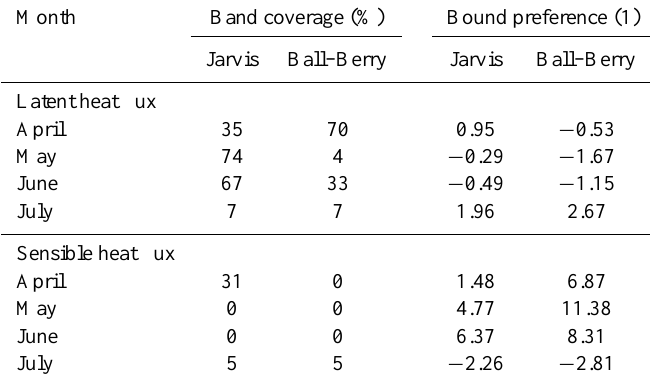
Figure 8. Measured and simulated monthly average diurnal cycles of sensible heat flux over a winter wheat stand in southwest Germany. For modelling, the NOAH-MP land surface model was used in two configurations. The stomatal resistance was computed either with the empirical Jarvis scheme or the photosynthesis-based Ball–Berry scheme. The grey band shows the post-closure methods uncertainty band computed as the difference between the raw and Bowen ratio-adjusted fluxes. The error bars indicate the random measurement error. In some cases, the error bars are smaller than the size of the symbol and therefore not visible. Table 4. Evaluation criteria of the Bowen ratio post-closure methods uncertainty bands presented in Figs. 7 and